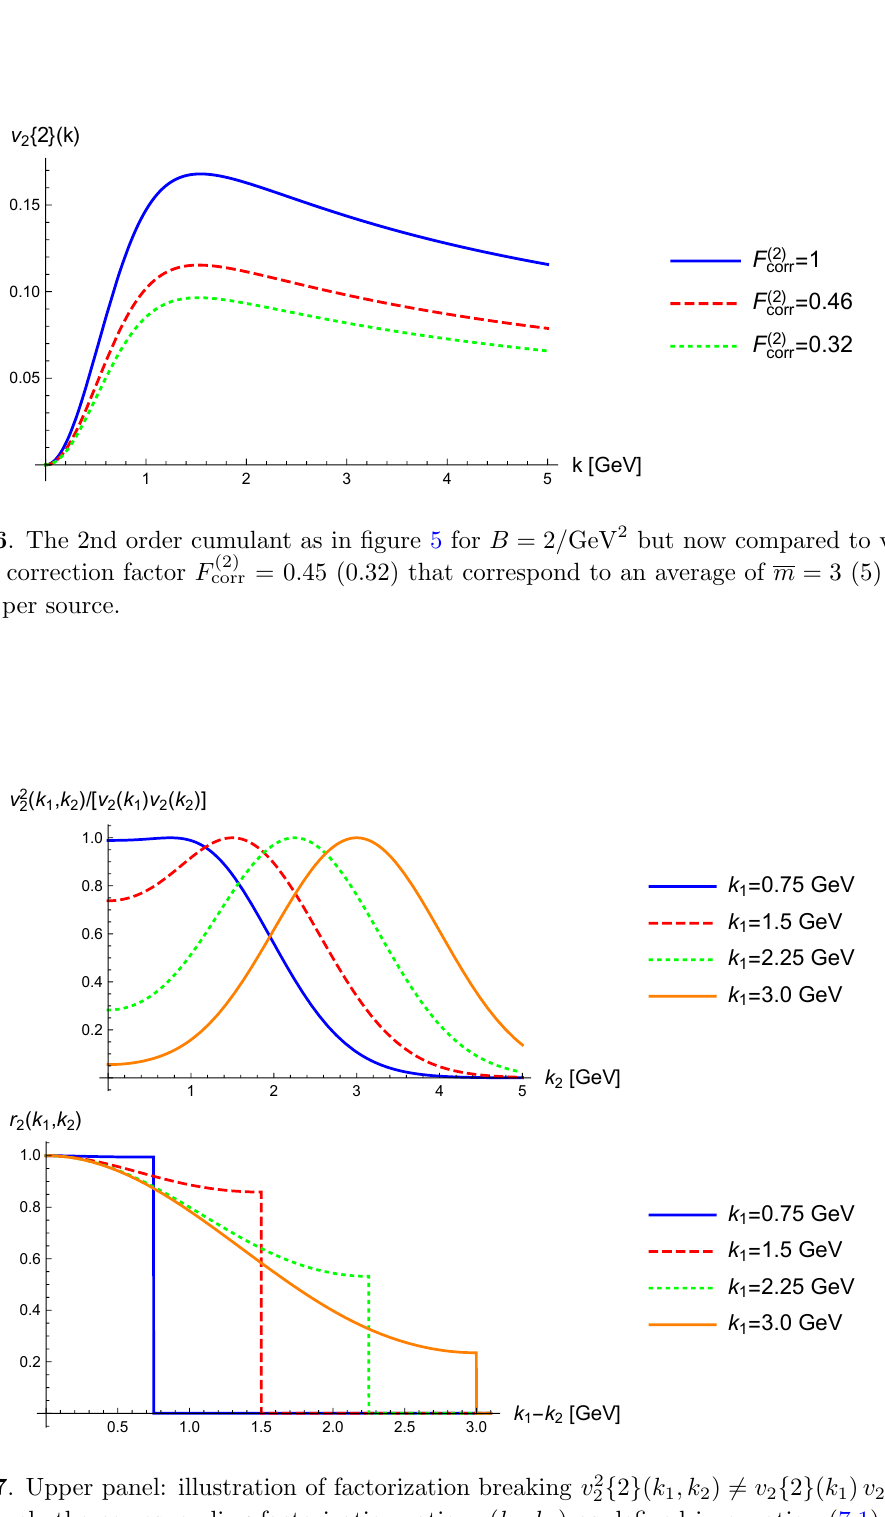
f 2 g ( k 1 ; k 2 ) 6 = v 2 f 2 g ( k 1 ) v 2 f 2 g ( k 2 ). 2